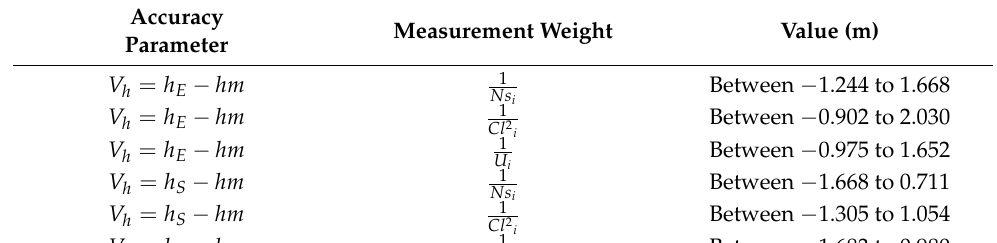
Table 4. The residuals along the h axis.